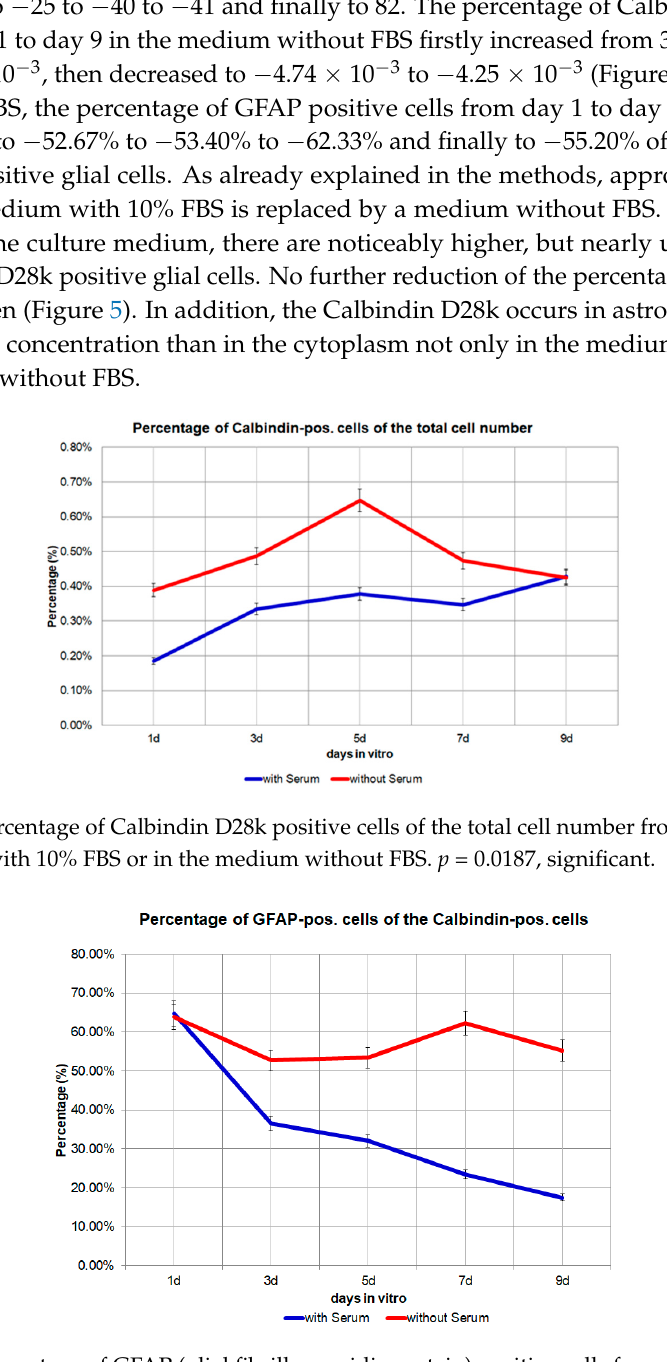
Figure 5. The percentage of GFAP (glial fibrillary acidic protein) positive cells from day 1 to day 9 in the medium with 10% FBS (fetal bovine serum) or in the medium without FBS. p = 0.0142, significant.